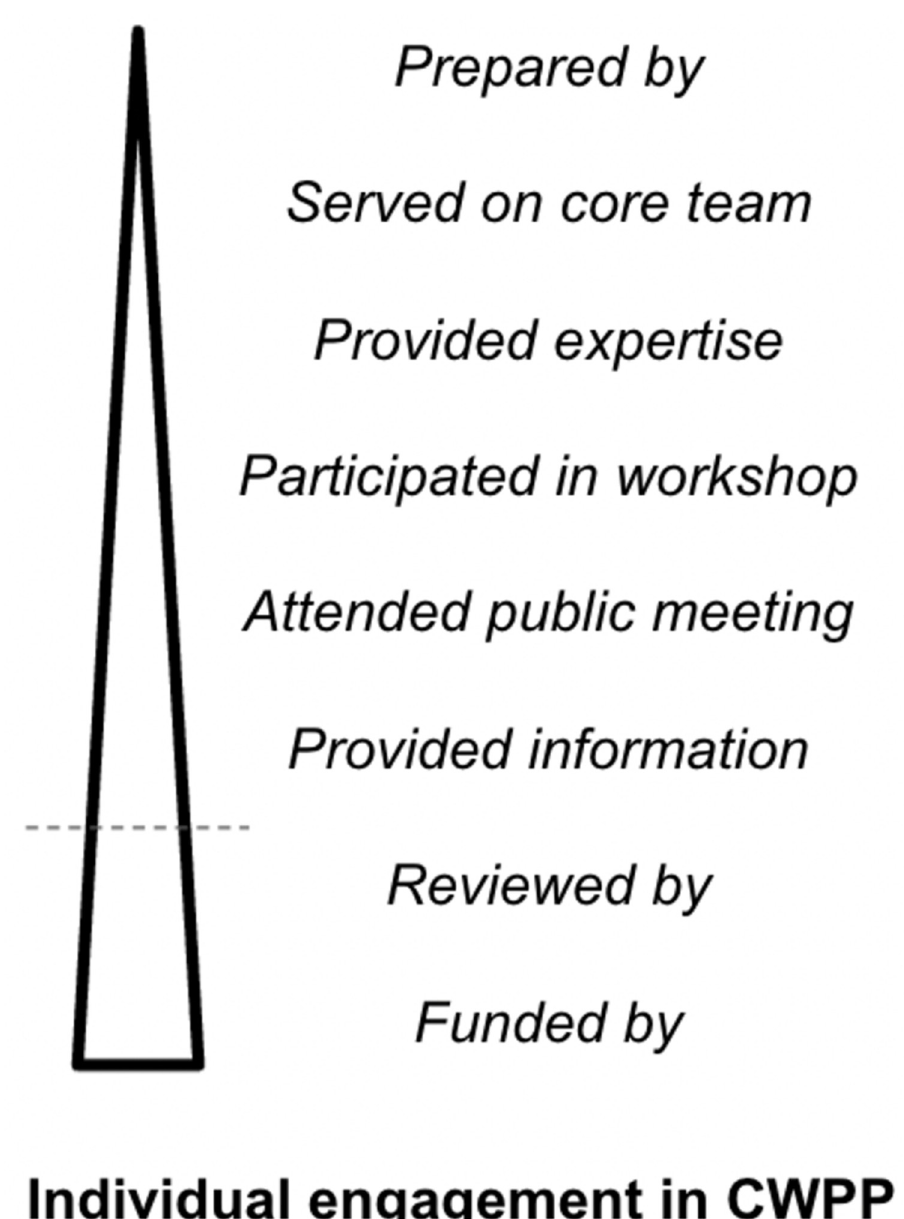
Fig 2. Common indicators of engagement by individuals within the CWPP. The dashed line represents the threshold of an individual engaging sufficiently to be considered a participant. Individuals above this line were considered participants in the CWPP and are the focus of this